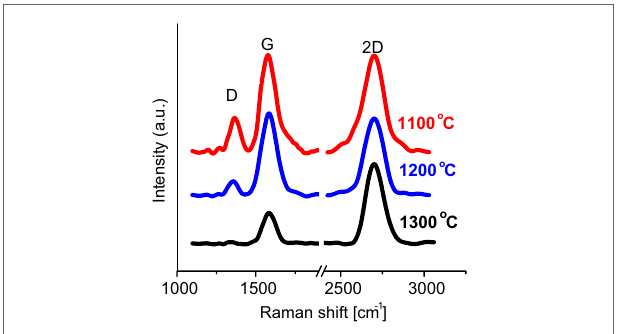
FiGURe 9 | Graphene deposition by means of PLD . Measured Raman spectra with respect to the growth temperature. Reproduced with permission from Zhang and Feng (2010b). Copyright 2010,